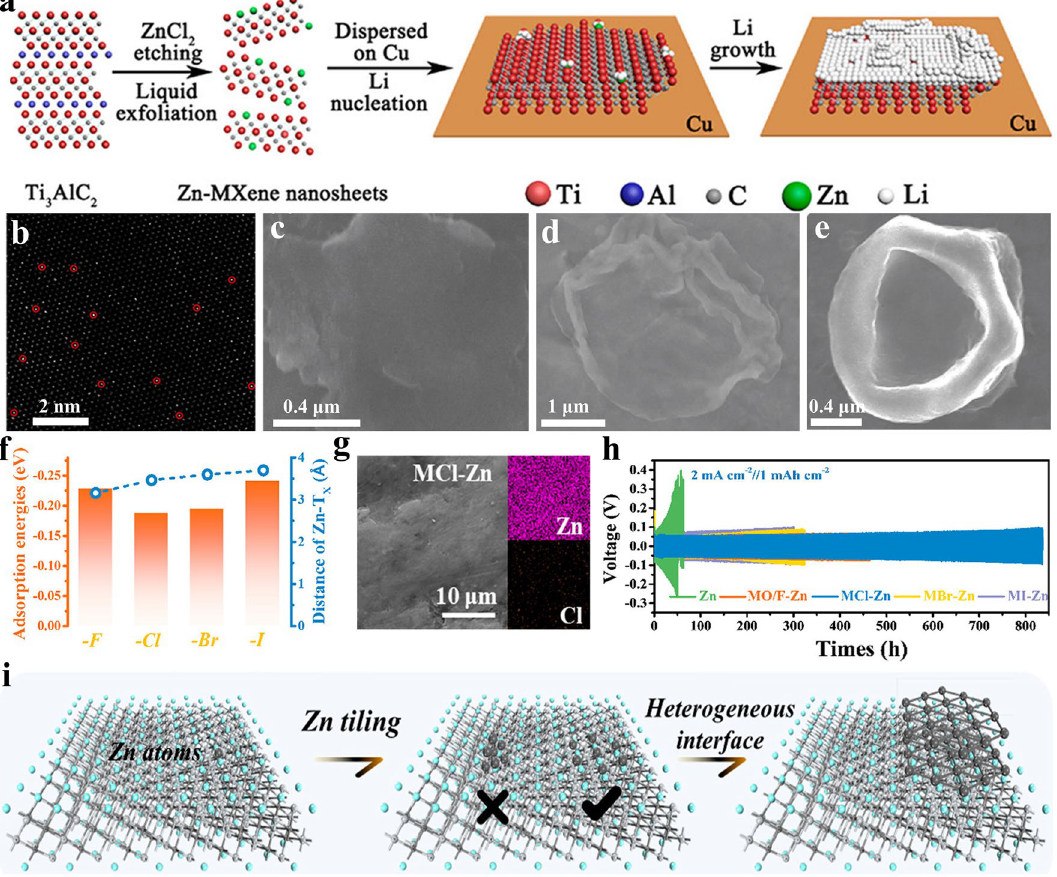
Fig. 13 a Schematic showing the preparation of Zn-MXene for Li nucleation and growth. b HAADF-STEM image of Zn-MXene nanosheets. c‑e SEM images of Zn-MXene nanosheets after Li plating with capacities of 5, 20 and 60 μAh cm −2 , respectively. Reproduced with permission from [156] Copyright 2020, American Chemical Society. f Calculated atomic distance between Zn atom and neighboring halogen termination as well as Zn adsorption energies of different MXene surfaces. g SEM image and EDS mapping of the Ti 3 C 2 Cl 2 -Zn electrode after cycling. h Long- term cyclic performance of various symmetric cells. i Schematic diagram of the Zn deposition process on the MXene substrate. Reproduced with permission from [212] Copyright 2021, American Chemical